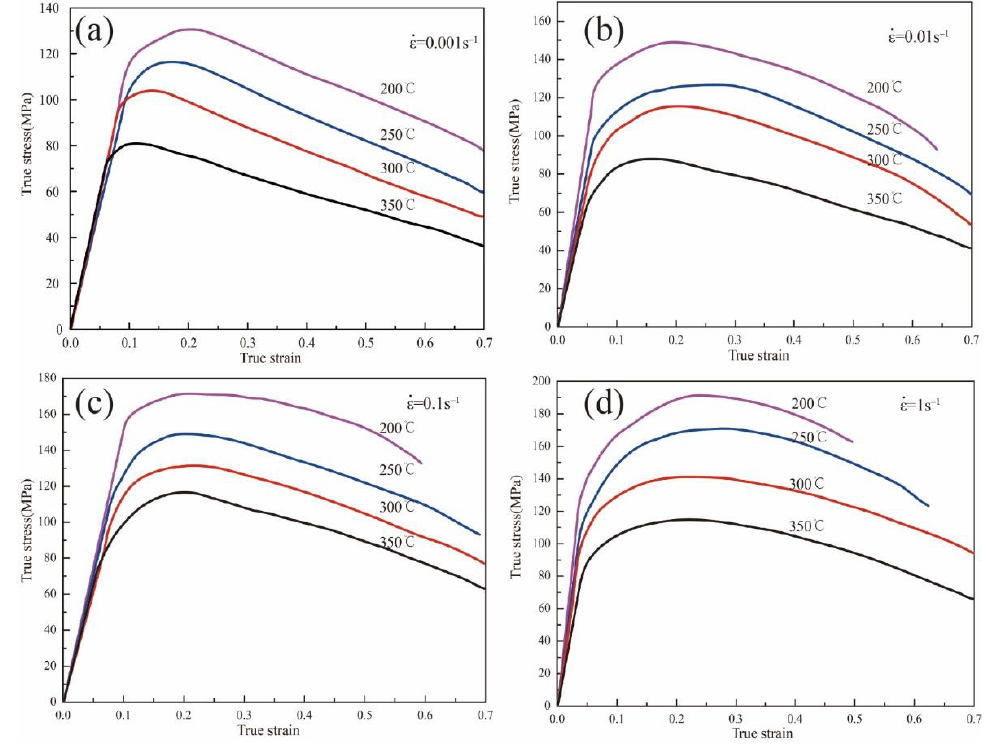
Figure 3. True stress – strain curves of the Mg 98.5 Zn 0.5 Y 1 alloy at various temperatures and strain rates. ( a ) 𝜀̇ = 0.001 s -1 ; ( b ) 𝜀̇ = 0.01 s -1 ; ( c ) 𝜀̇ = 0.1 s -1 ; ( d ) 𝜀̇ = 1 s -1 .